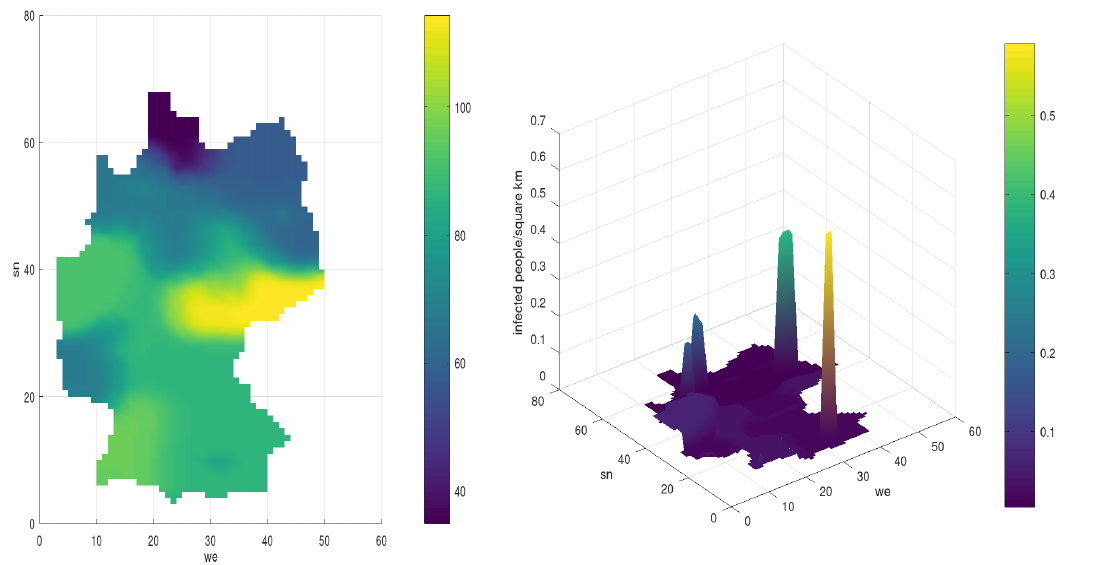
Figure 8. Forecast of the seven-day incidence, s , ( left panel ), and distribution of people with COVID-19 ( right panel ) after 20 days, for the SIR-model coupled with the diffusion